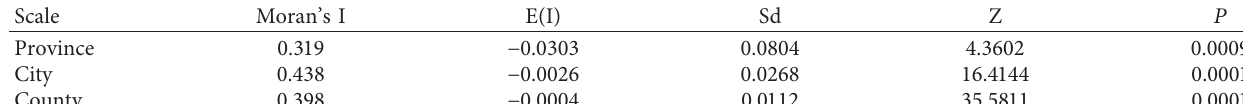
Table 2: Moran index of pro-poor tourism villages.